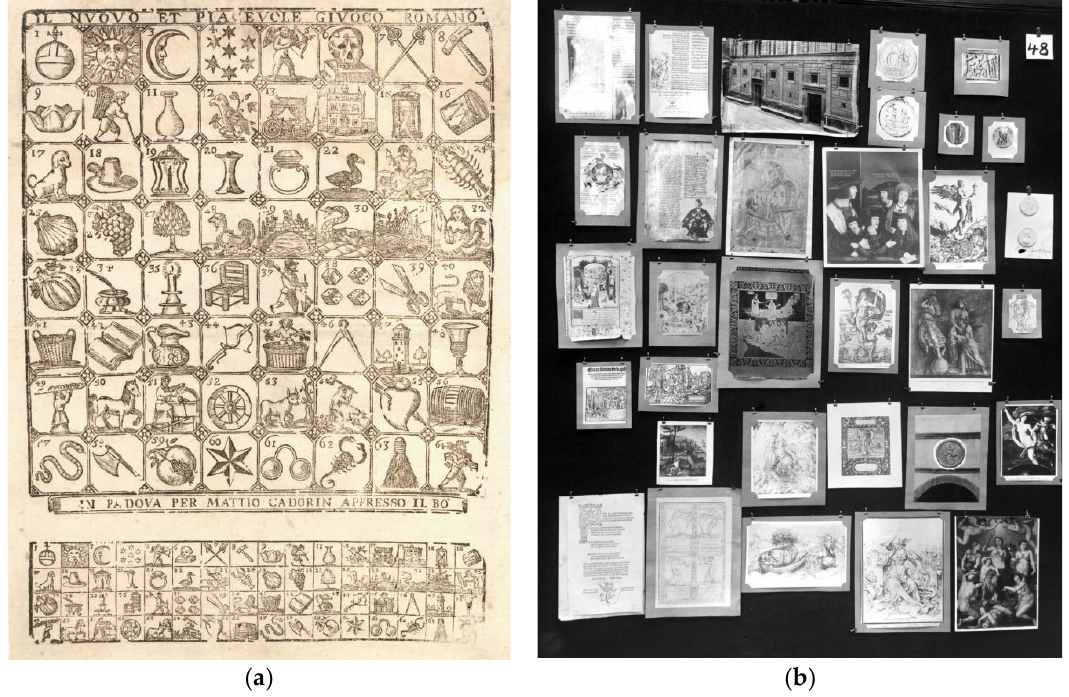
Figure 5. ( a ) Game of Biribissi , XVII secolo; ( b ) Warburg, A. Mnemosyne , 1924–1929, Table